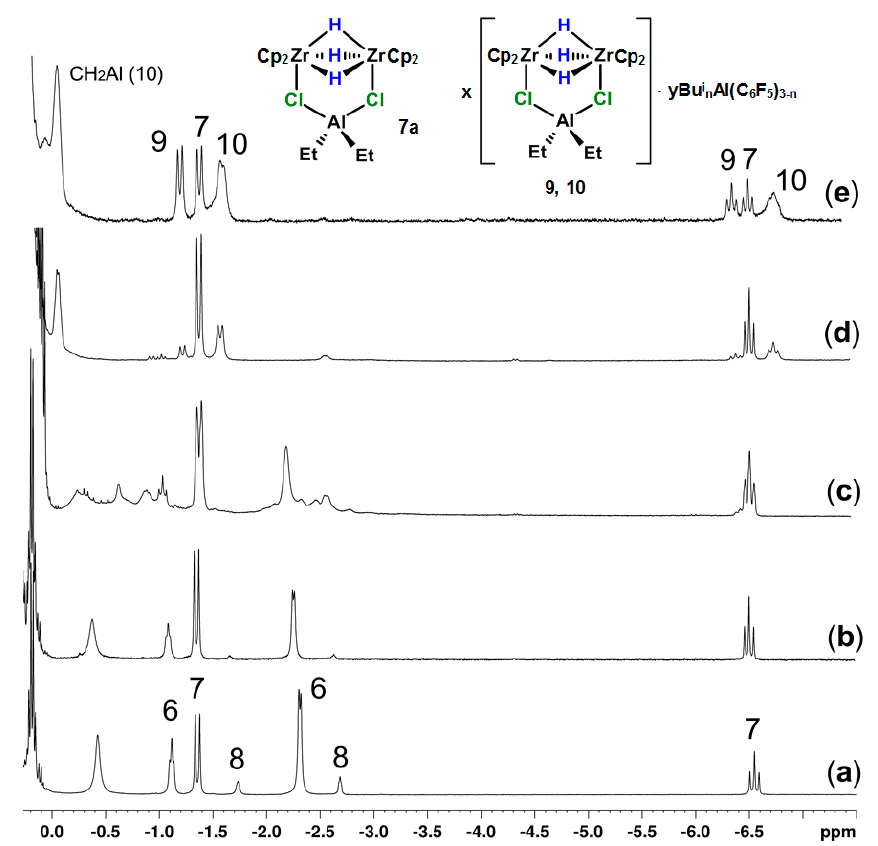
Figure 2. 1 H NMR of the [Cp 2 ZrH 2 ] 2 -ClAlEt 2 -(Ph 3 C)[ B(C 6 F 5 ) 4 ] system in С 6 D 6 (T= 299 K): ( a )